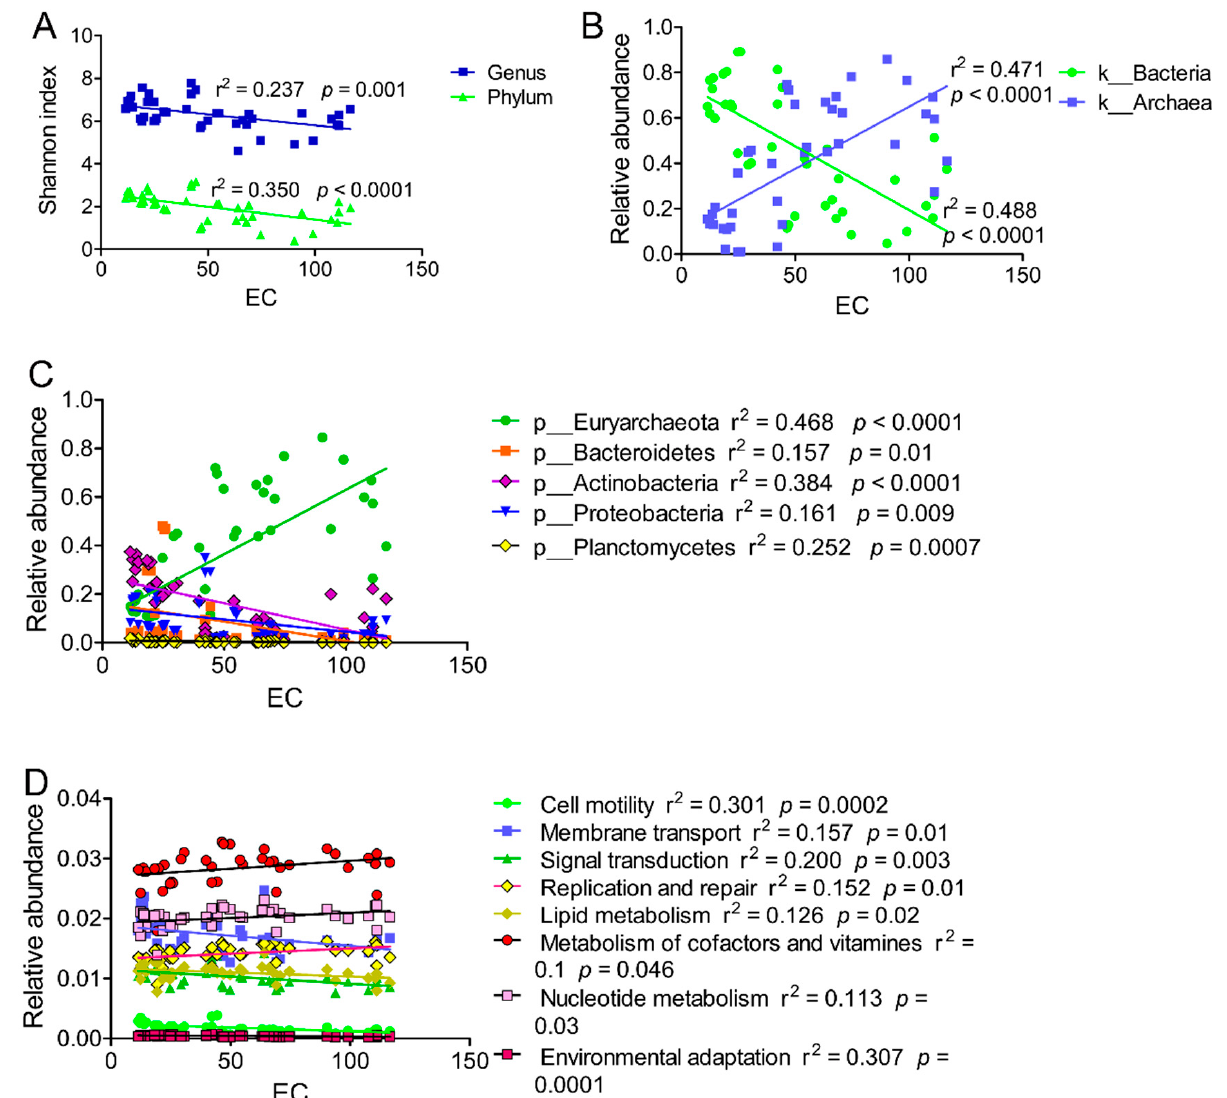
Figure 10. Regression analysis of EC and Shannon index ( A ), and relative abundance at kingdom ( B ) and phylum level ( C ), and KEGG at level 2 ( D ).